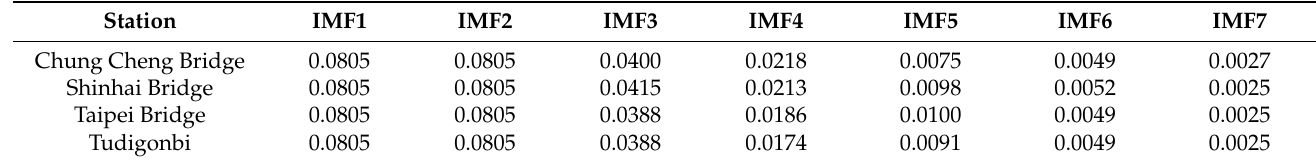
Table 2. Frequency (hr − 1 ) of the gauging